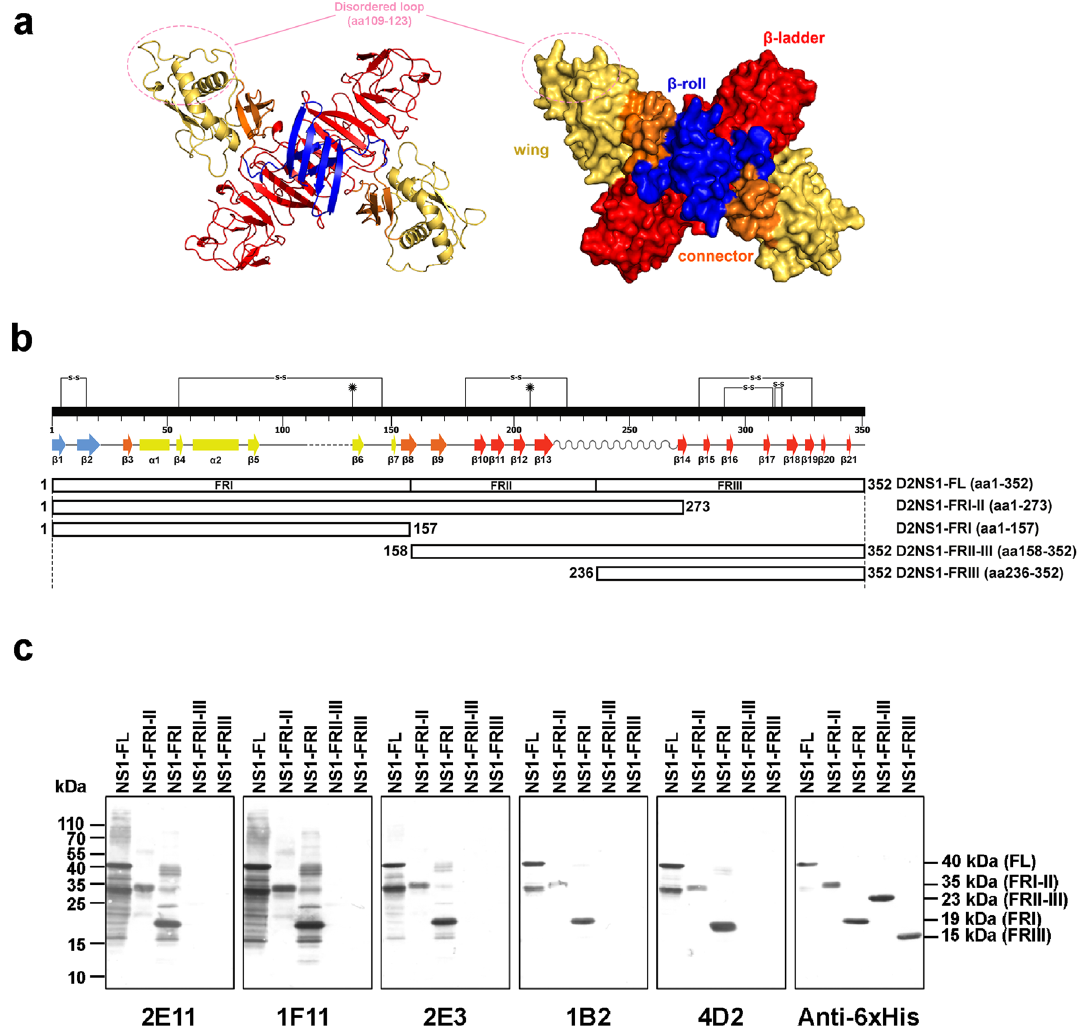
Figure 2. Mapping of NS1 fragments recognized by anti-NS1 antibodies. ( a ) Dimeric DENV2 NS1 structure. Each monomer contains the domains: β-roll (blue, aa 1 − 29), Wing (yellow, 38 − 151) and β-ladder (red, aa 181 − 352) connected by discontinuous subdomains (orange, aa 30 − 37 and aa 152 − 180). Secondary structure view (left) and three-dimensional structure view (right). The NS1 structure was modeled with SWISS- MODEL 34,35 . An input of full-length amino acid sequence of DENV2 NS1 were used in order to depict missing residues in the template crystal structure (PDBID: 4O6B). PyMol was used for structure visualization (The PyMOL Molecular Graphics System, Version 2.0 Schrödinger, LLC.). ( b ) The schematic diagram of recombinant truncated NS1 fragments: The full-length DEN2NS1 (NS1-FL) (aa 1 − 352) can be divided into three fragment domains (FRI, FRII, and FRIII). Four truncated DEN2NS1 recombinant proteins spanning these fragments were generated: NS1-FRI, (aa 1 − 157); NS1-FRI-II (aa 1 − 273); NS1-FRII-III (aa 158 − 352), and NS1-FRIII (aa 274 − 352). The DENV2 NS1 secondary structure elements and corresponding amino acid residues are shown above. ( c ) Reactivity of anti-NS1 mAbs to rNS1-FL and its truncated fragments. E. coli lysates expressing various rNS1 fragments were analyzed by western blot with five anti-NS1 mAbs indicated below each panel (2E11, 1F11, 2E3, 1B2, and 4D2). Equivalent amounts of rNS1 fragments were loaded in each lane as shown by western blot with anti-6His antibody. The molecular sizes in kDa of all fragments are shown on the